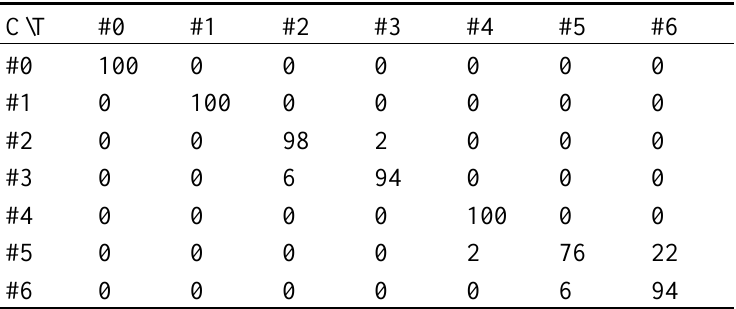
Table 2. Classification efficiency for a 750 ms window. States are numbered from #0 to #6. The tested (T) input states are enumerated on the top row. Each clas1 CM sified (C) output state is located on the left